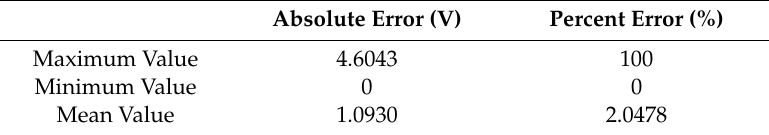
Figure 24. PVSE output percentage error. Table 4. Summary of the errors obtained.